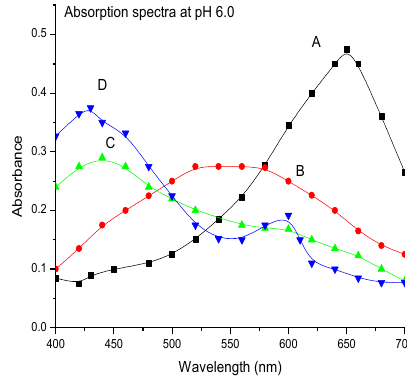
Figure 3. Absorption spectra of Eu at pH 6.0, A- ECAB-CDMEAB-Eu-(Ternary complex). B- ECAB-Eu at(pH 6.0)-(Binary complex), C -ECAB-CDMEAB-(Modified reagent), D -ECAB-(Reagent).